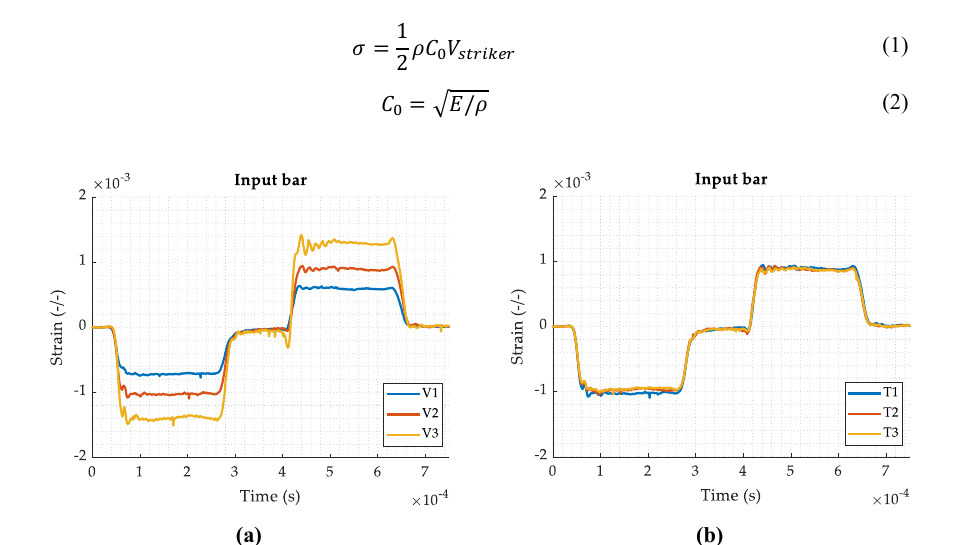
Fig 3. Evolution of the strain in function of time, measured on the input bar: (a) at constant temperature (293 K) for 3 impact speeds (V1 = 6 m/s, V2 = 11 m/s and V3 = 13.2 m/s), (b) at constant impact speed (11 m/s) for 3 temperatures (T1 = 293 K, T2 = 373 K and T3 = 473 K).